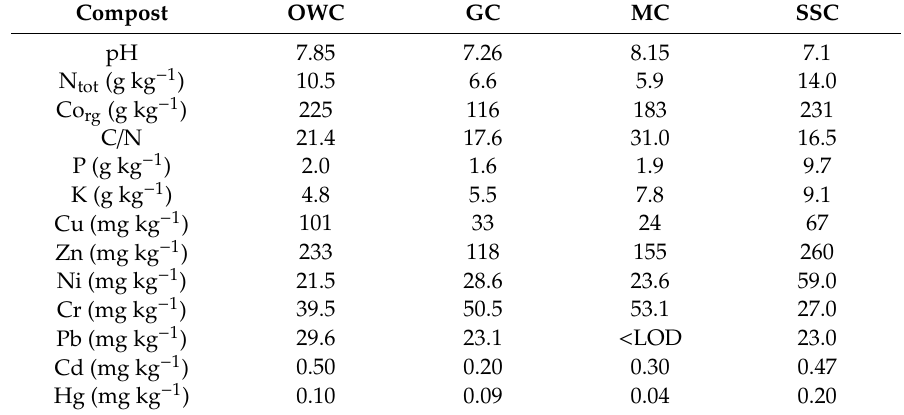
Table 1. Physicochemical properties of the four di ff erent composts (compost sampled in 2018). Compost OWC